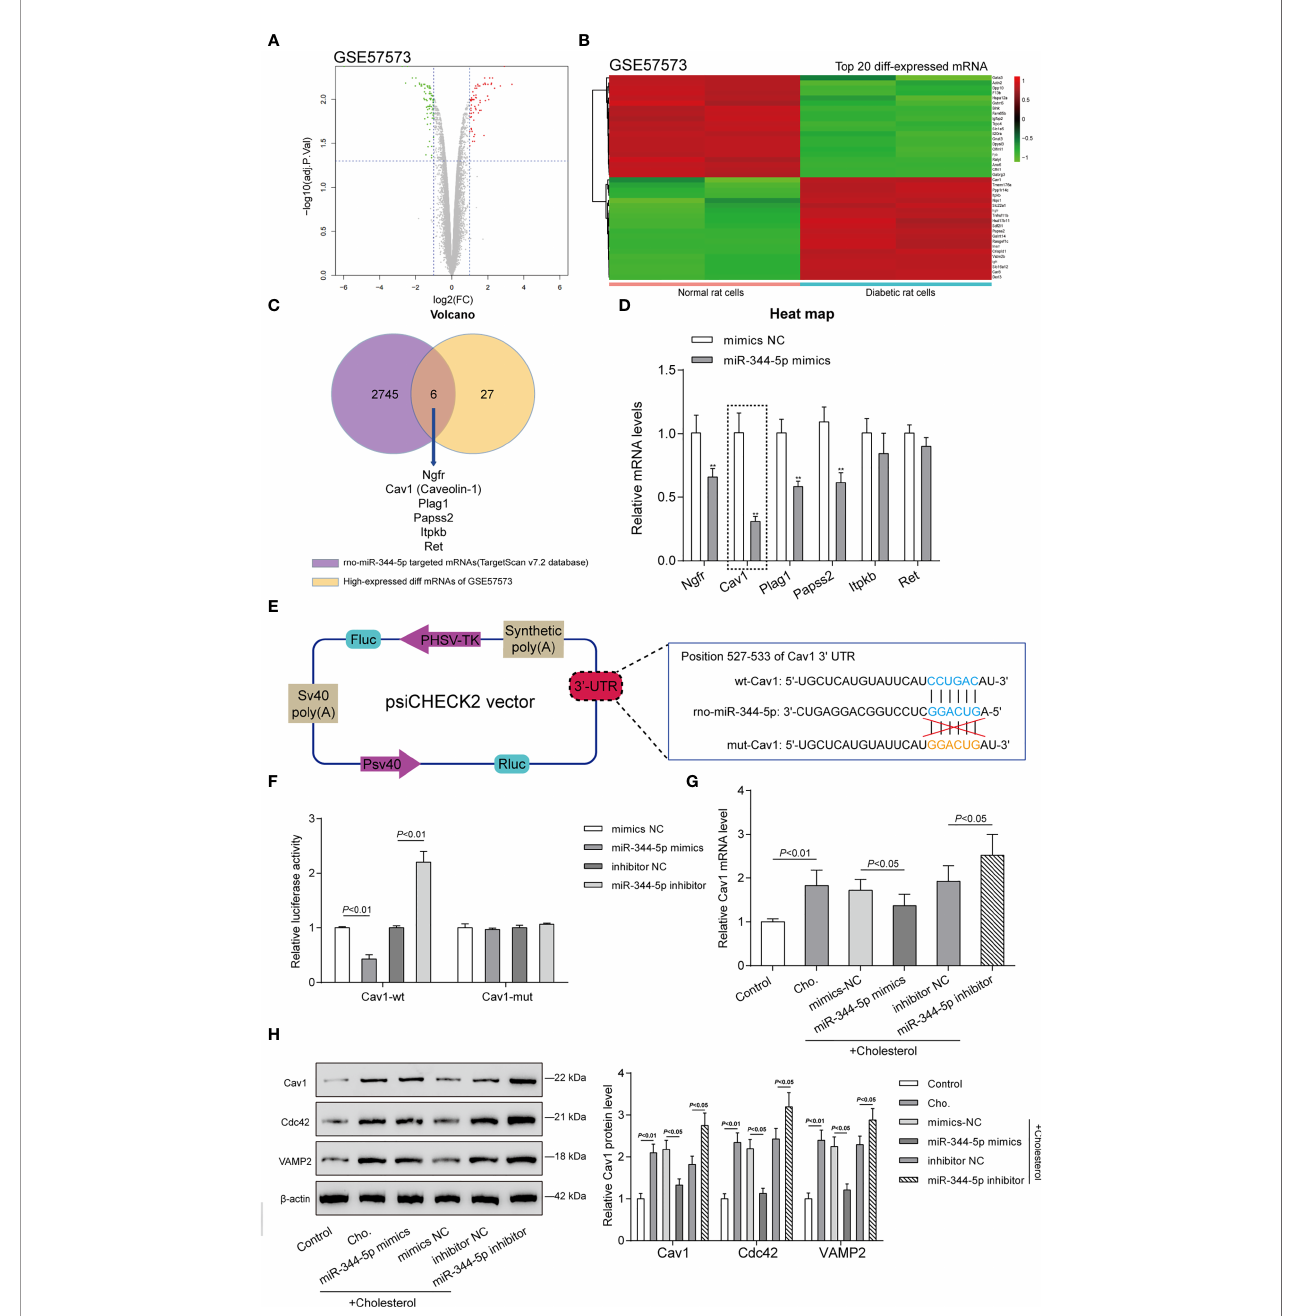
FIGURE 4 | Caveolin-1 (Cav1) is a direct downstream target of miR-344-5p. (A) Volcano plots of abnormally upregulated and downregulated mRNAs between normal and human islet amyloid polypeptide (hIAPP)-treated INS-1E cells (type II diabetic cell model) based on GSE57573. Green plots represent 37 downregulated mRNAs, and red plots represent 33 upregulated mRNAs. (B) Hierarchical clustering heatmap showing the top 20 differentially expressed mRNAs between normal and hIAPP-treated INS-1E cells based on GSE57573. (C) TargetScan 7.2 was used to predict miR-344-5p target genes, and 2,751 mRNAs were obtained; these predicted target genes and 33 upregulated mRNAs in GSE57573 intersected at Ngfr, Cav1 (Caveolin-1), Plag1, Papss2, Itpkb, and Ret. Through literature review, Cav1 was chosen for further study. (D) INS-1 cells were transfected with miR-344-5p mimic and examined for these six genes ’ expression levels by real-time PCR. ** P < 0.01, ** P < 0.001 compared to mimics NC group. (E) Diagram depicting the 3 ’ -UTR reporter constructs. The Cav1 3 ′ UTR fragments of rat were inserted into the psiCHECK-2 vector downstream of the Renilla luciferase. (F) Dual-luciferase reporter assay was performed to verify the predicted binding between miR-344-5p and Cav1. (G, H) INS-1 cells were transfected with miR-344-5p mimic or inhibitor for 48 h, treated with 5 mM cholesterol for 12 h, and examined for Cav1 mRNA (G) and Cav1, VAMP2, and Cdc42 protein (H) expression levels by real-time PCR and